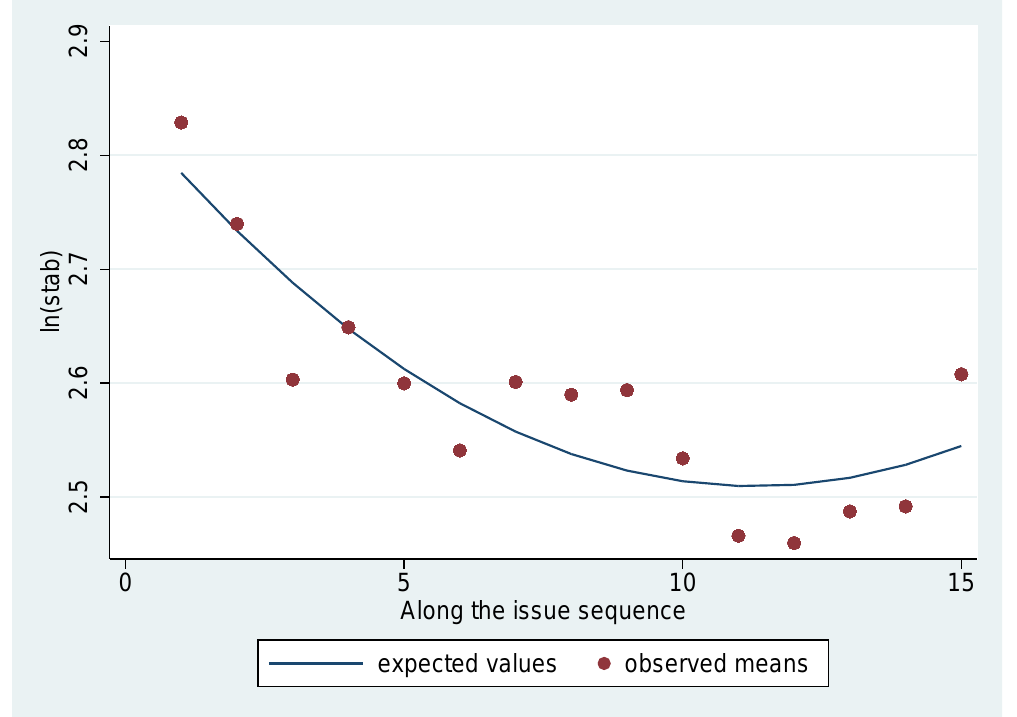
Figure 9: Evolution of ln(stab) along the issue sequence. Balanced random-intercept fixed effects longitudinal design; STATA 12 xtreg implementation; n = 450; plot of expected values based on the estimated β constant = 2.840 (s.e. = 0.075), p ≤ 0.001; β s = − 0.059 (s.e. = 0.022), p ≤ 0.01, β R-square (overall)